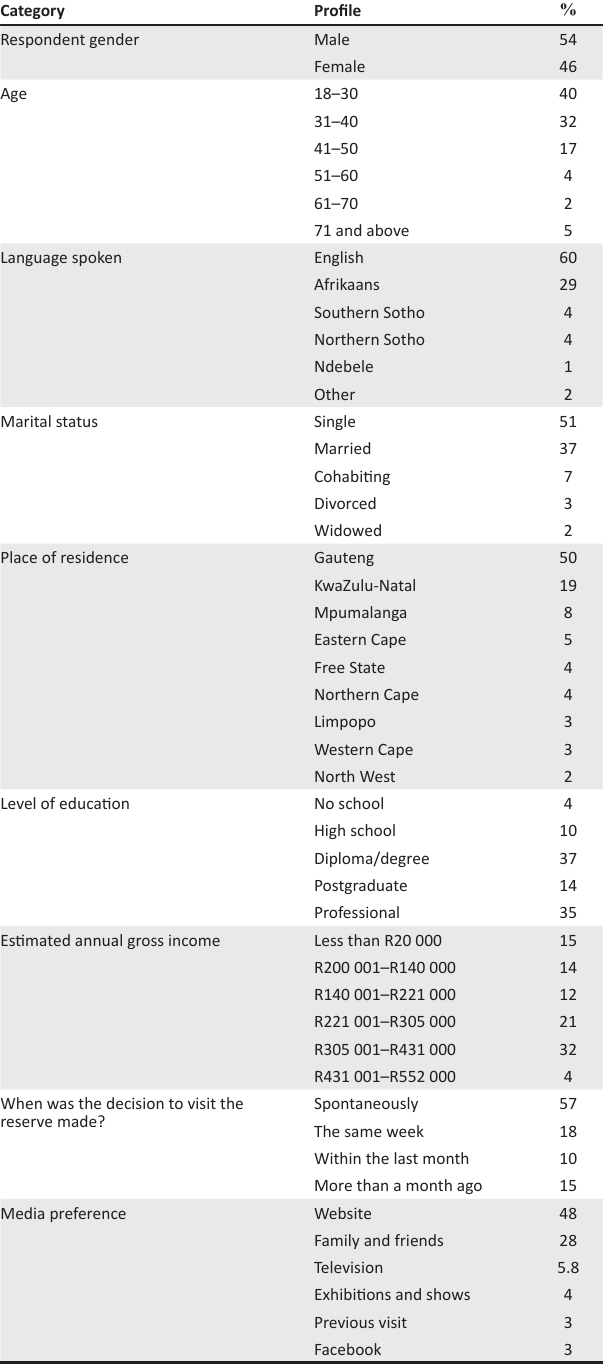
TABLE 2: Demographic profile of respondents.